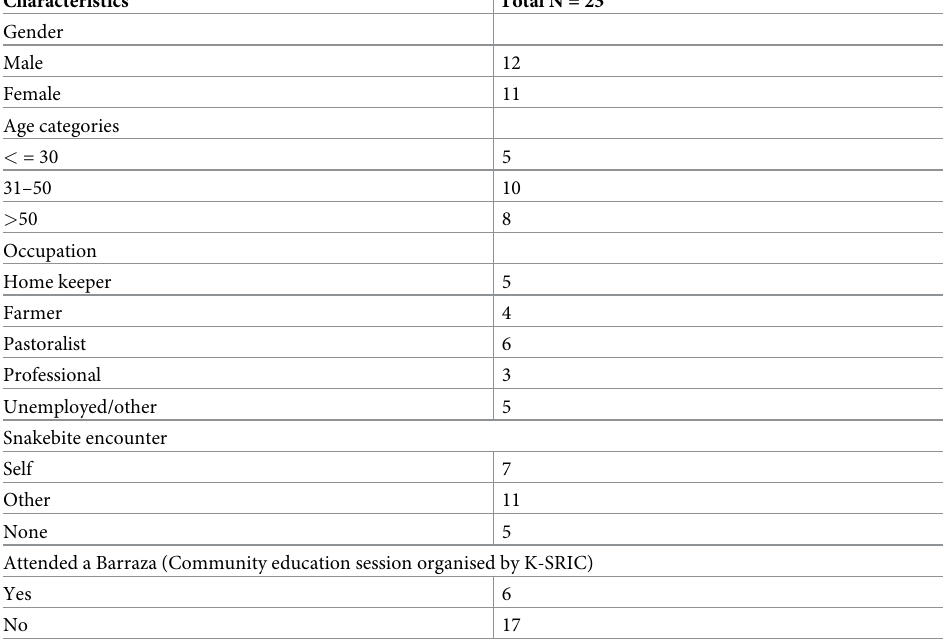
Table 2. Sociodemographic characteristics of study